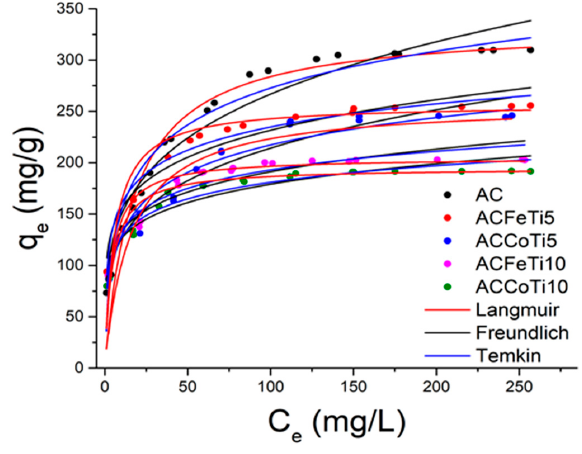
Figure 4. Regression analysis of adsorption isotherms of CYF-4G on AC, ACFeTi5, ACFeTi10, ACCoTi5, and ACCoTi5 using Langmuir, Freundlich, and Temkin (conditions: 1.2 g/L of adsorbent dosage, 120 rpm and 4 h agitation time, pH = 2, and T: 25 °C).